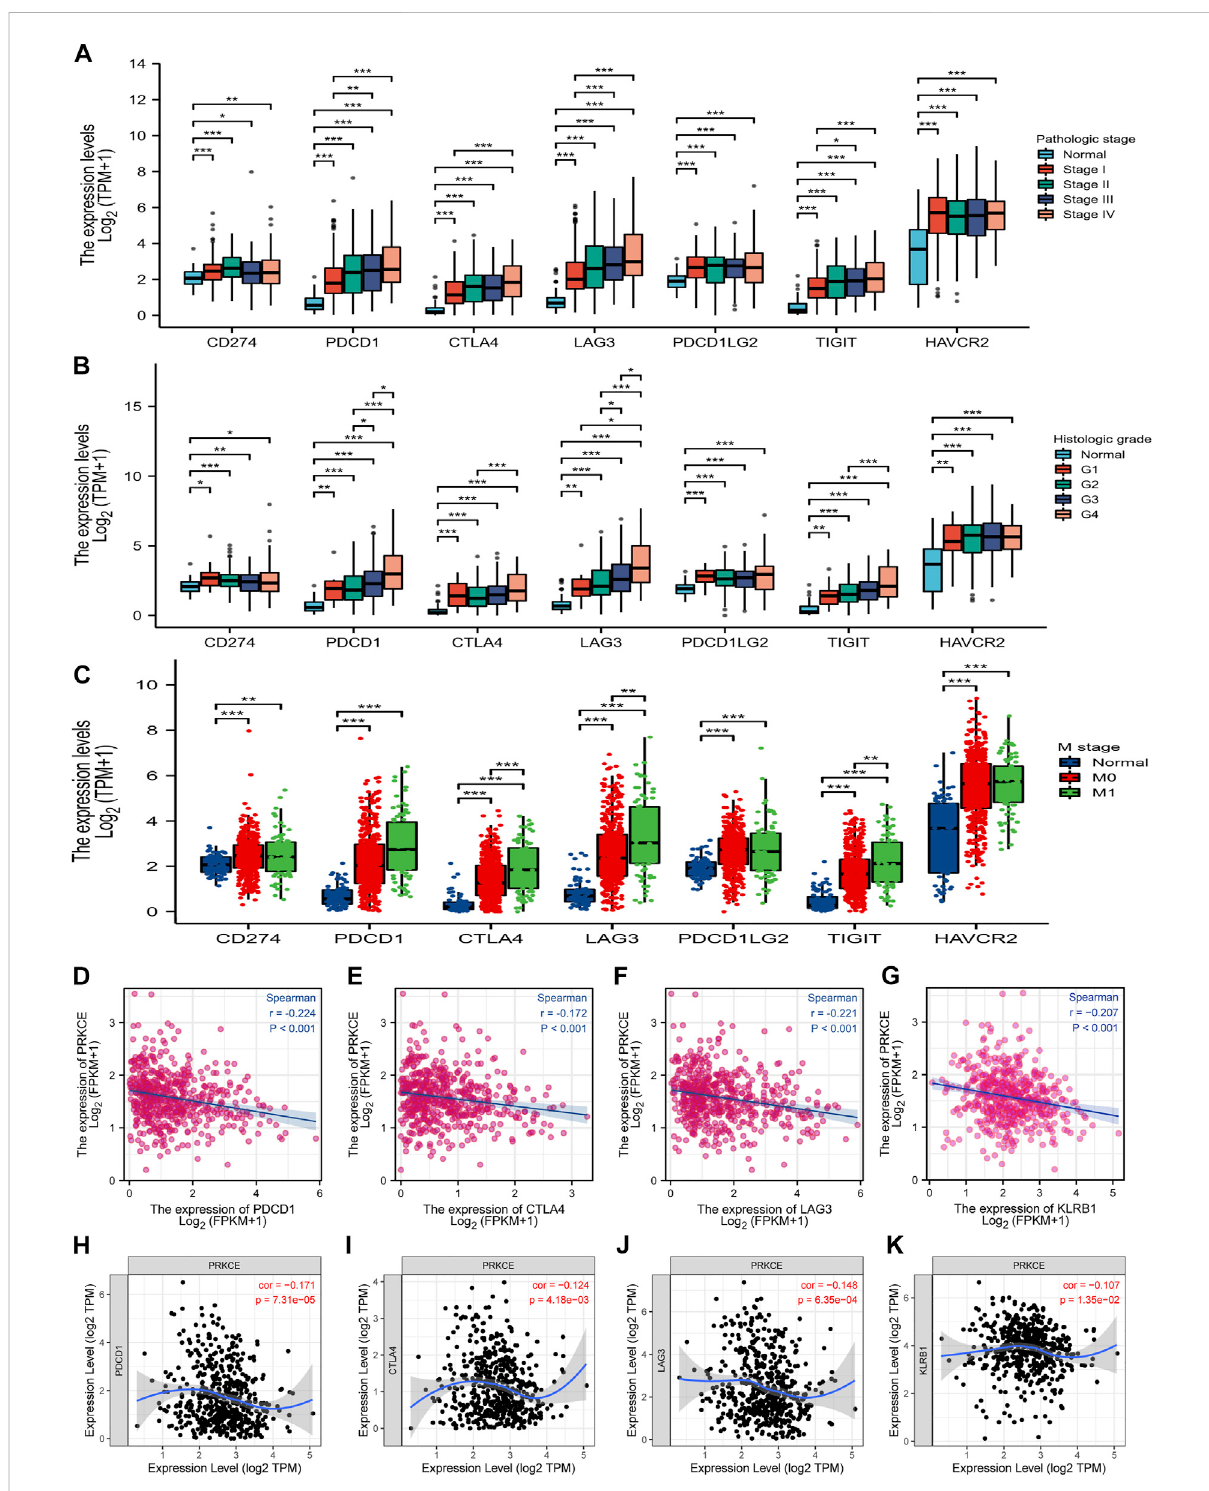
FIGURE 7 The relationship between PRKCE expression and immune checkpoint genes in KIRC. The expression of CD274 (PDL1), PDCD1 (PD1), CTLA-4, LAG3, PDCD1LG2 (PDL2), TIGIT, and HAVCR2 (TIM-3) in (A) pathologic stage I, II, III; (B) histologic grade G1, 2, 3, 4 and (C) M stage M0, M1. (D – G) PRKCE expression was negatively correlated with the checkpoint molecules in KIRC. Markers include PDCD1 (PD1), CTLA4, LAG3, and KLRB1. (H – K) The expression correlation of PRKCE with PDCD1, CTLA4, LAG3, and KLRB1 in KIRC was investigated by